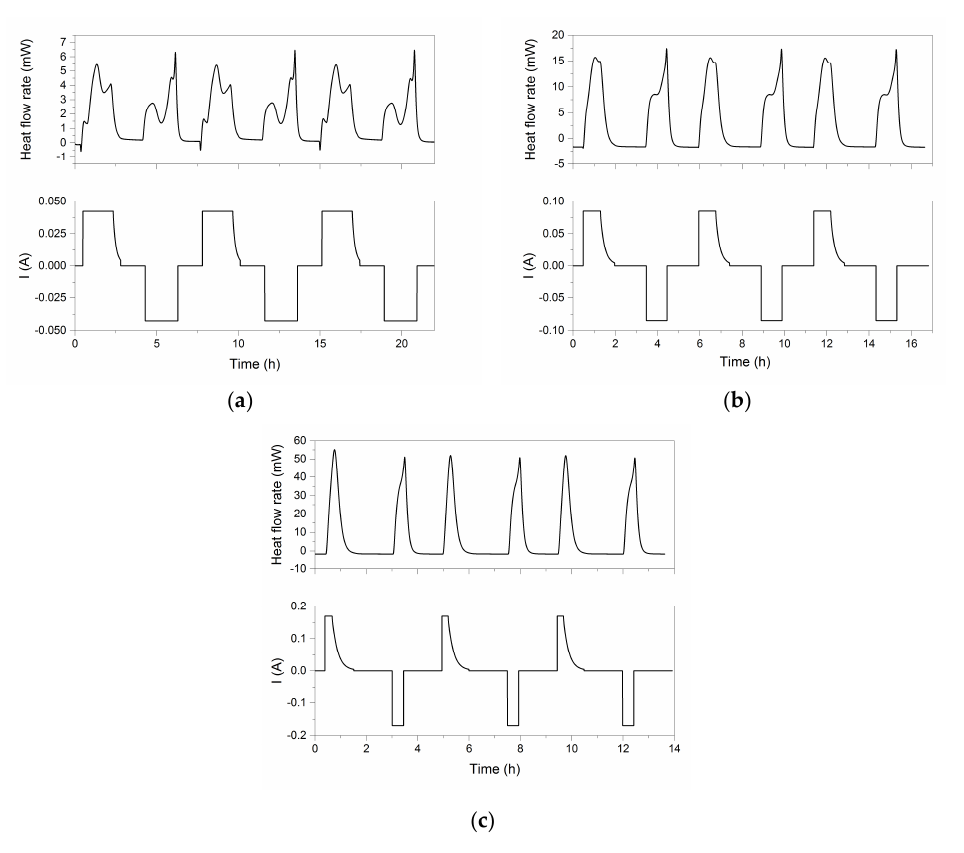
Figure 7. The heat flow rates for joule effect calibrations.